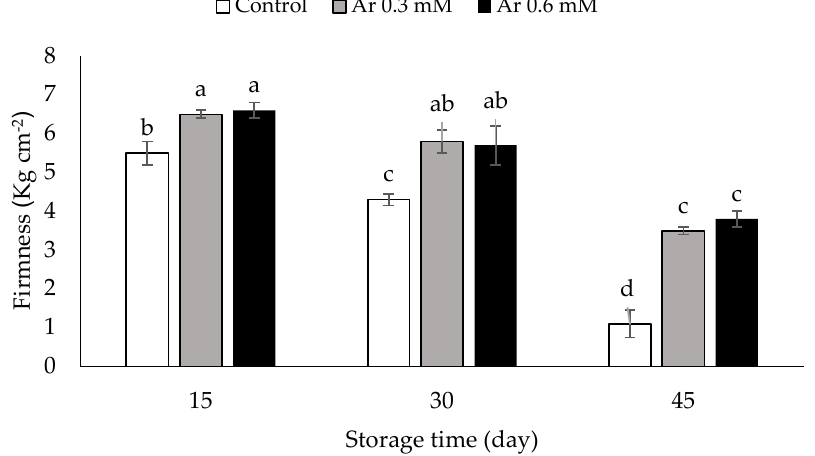
Figure 3. The effect of different levels of postharvest treatment of L-arginine on the firmness of persimmon cv. “Karaj” fruits during cold storage (DMRT, p ≤ 0.05). The values of data are average of n = 3, and bar represents standard error of the means. Different letters above the bars show significant difference at p < 0.05 by Duncan’s multiple range test.